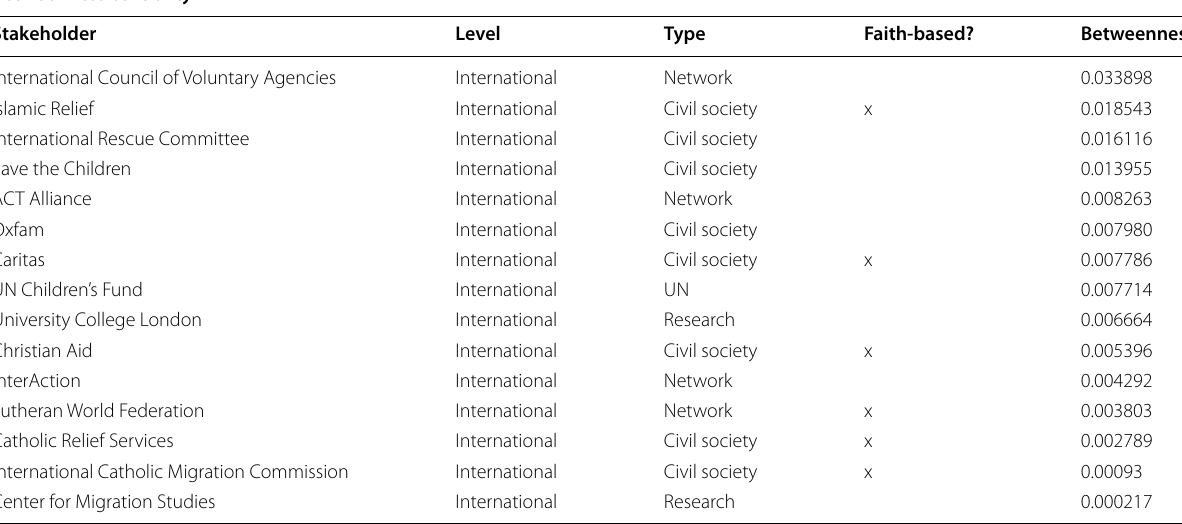
Table 5 Betweenness centralities of identified stakeholders Betweenness